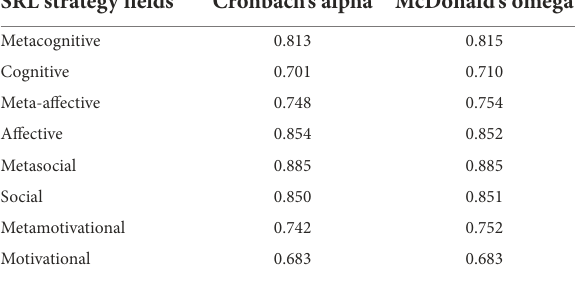
TABLE 3 Reliability values for the SRFLLSQ questionnaire fields.